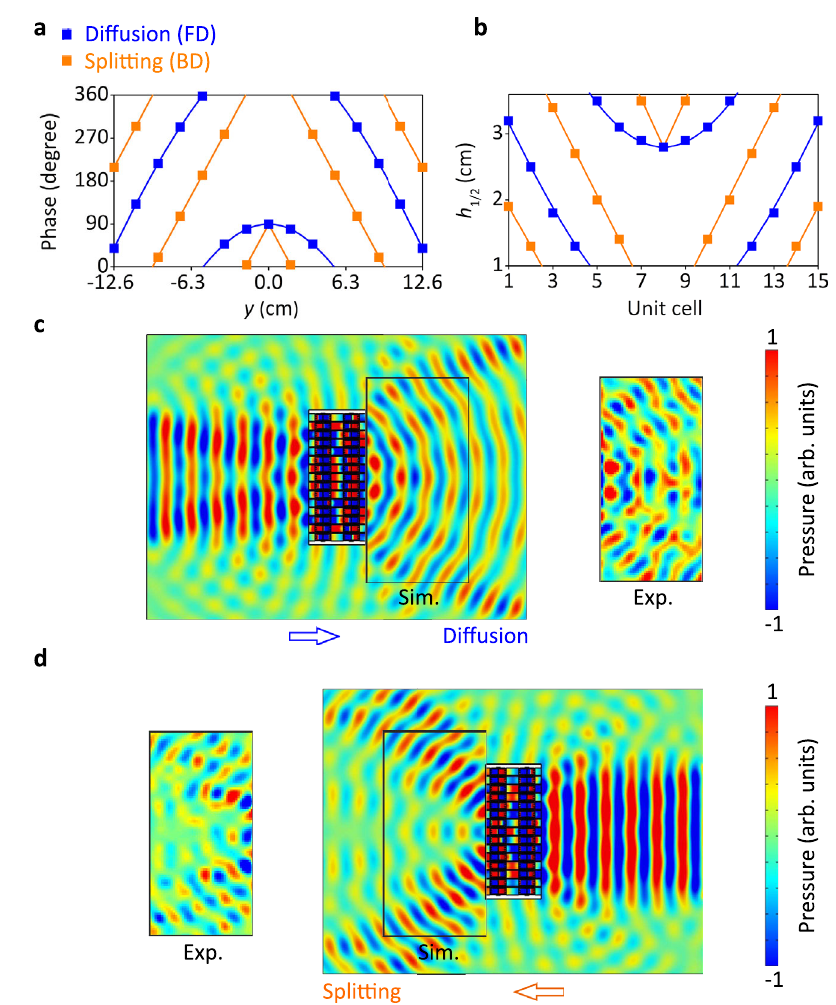
Fig. 8 Two-faced wavefront manipulation, encoding diffusion for FD (forward direction), and splitting for BD (backward direction). a Phase pro fi les of acoustic diffusion for FD and beam splitting for BD are φ 1 = 11.78 − 117.8(( x − 0.1) 2 + y 2 ) 0.5 + π /2 rad and φ 2 = − 83.3 | y | + π /2 rad, respectively. b Corresponding h 1 and h 2 values for FD and BD, respectively. c , d Corresponding simulated (sim.) and experimental (exp.) acoustic pressure distributions at 6430 Hz for PD in ( c ) and BD in ( d